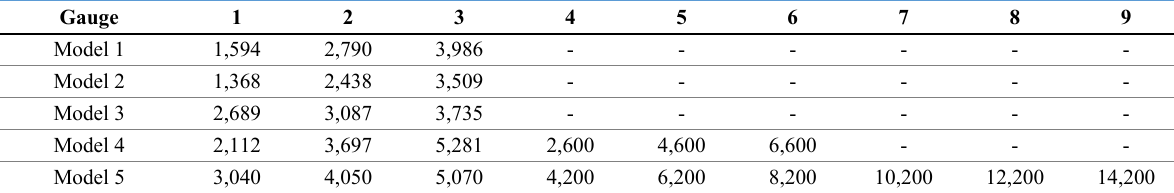
Table 10. Distance in meters from the external gauges to the explosion center.